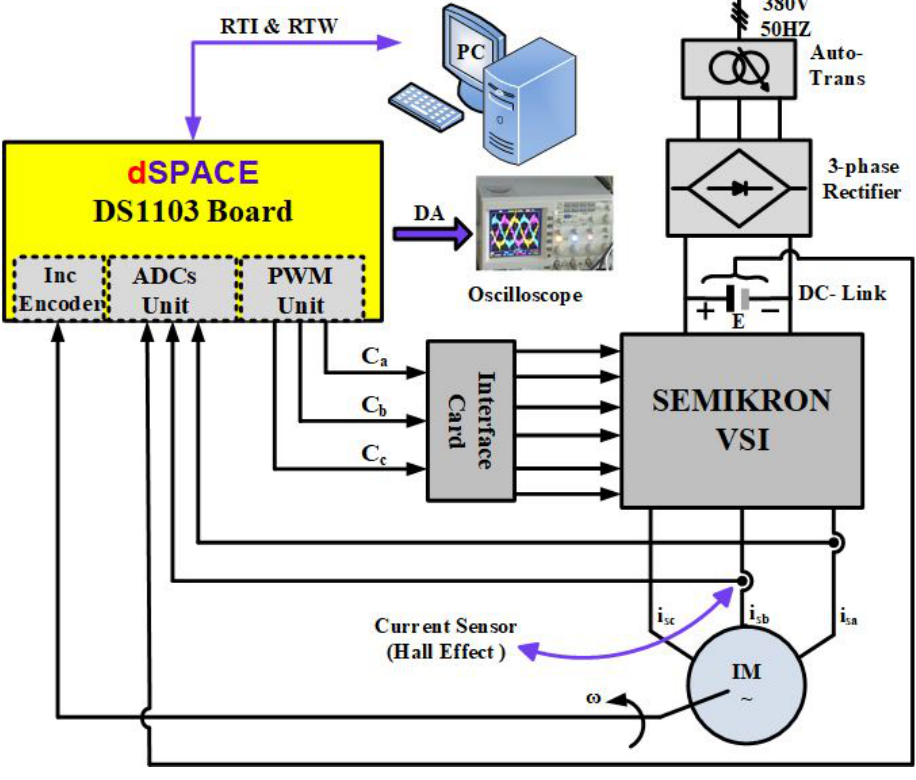
Figure 25. Experimental setup of IM-based drive system.